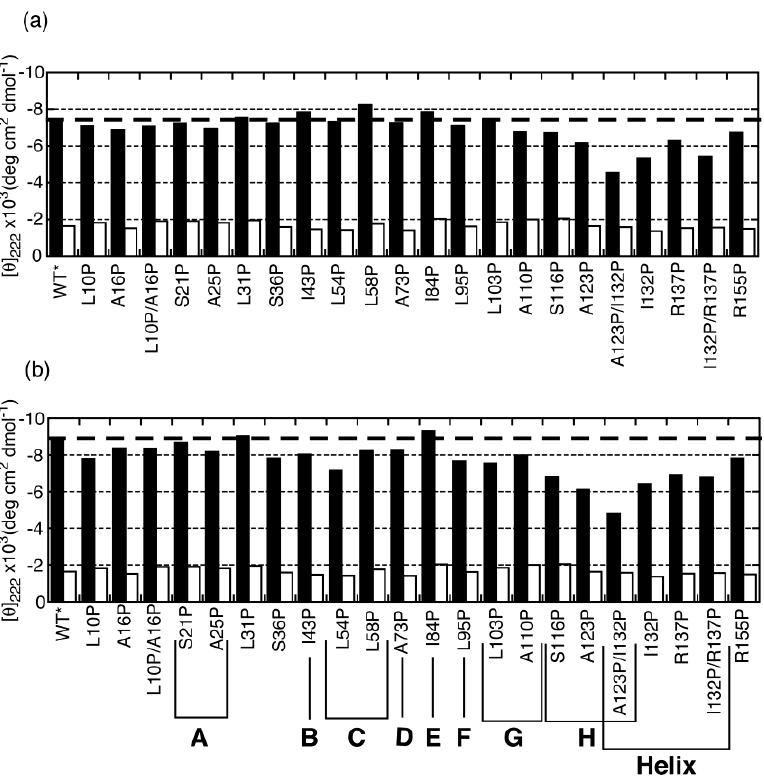
Figure 4. [  ] in the A, C, and U states of pseudo-wild-type (WT*) and its proline 222 mutants. (a) [  ] for WT* and all proline-substituted mutants in the A state (solid bars) 222 and in 6 M GdnHCl (open bars). (b) [  ] for WT* and all proline-substituted mutants in 222 the C state (solid bars) and in 6 M GdnHCl (open bars). The dashed line represents [  ] for WT*. The secondary-structure elements in which the proline-substituted residues are included are shown in the bottom panel (b) . Adapted with permission from reference [24]. Copyright 2006 American Chemical Society.